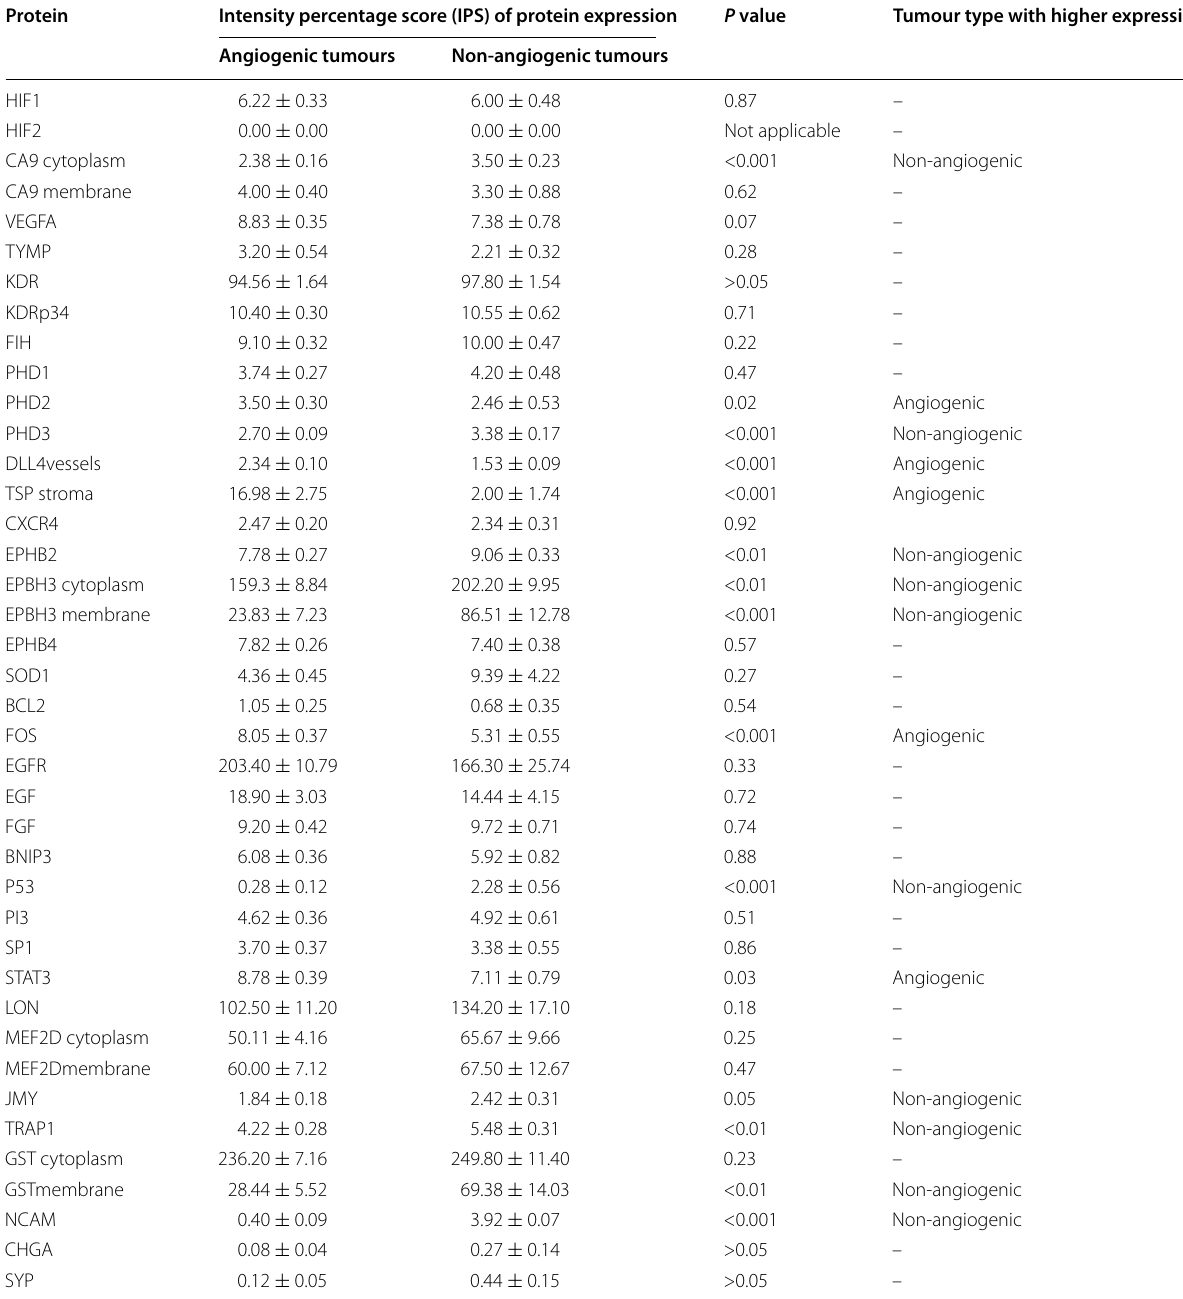
Table 4 Cytoplasmic and membranous expression of the proteins in angiogenic versus non-angiogenic non-small cell lung cancers